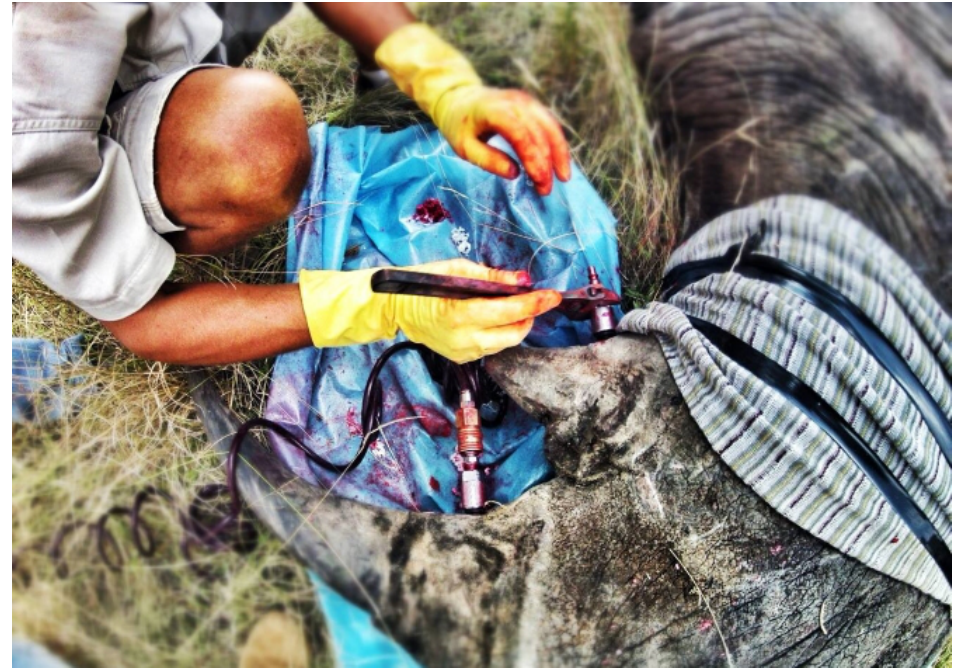
Figure 5. A snapshot of dyeing and removal of the rhino’s horn in an attempt to stop poaching. The horn is poisoned with chemical to make the horn useless to consume